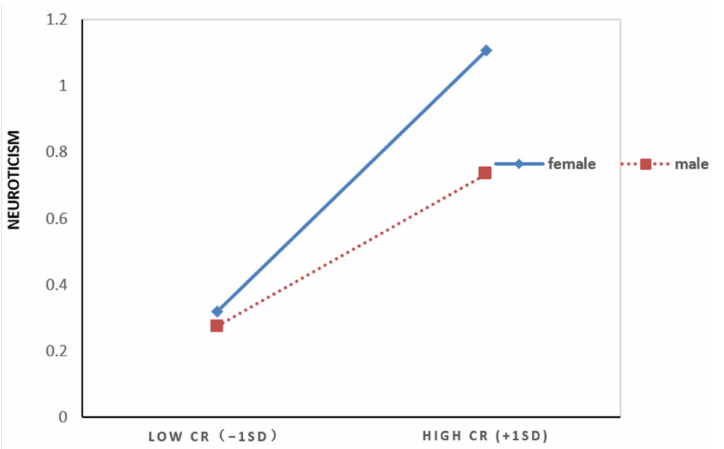
Figure 3. Moderating effect of gender in the relationship between cumulative ecological risk and neuroticism. Note. CR: cumulative ecological